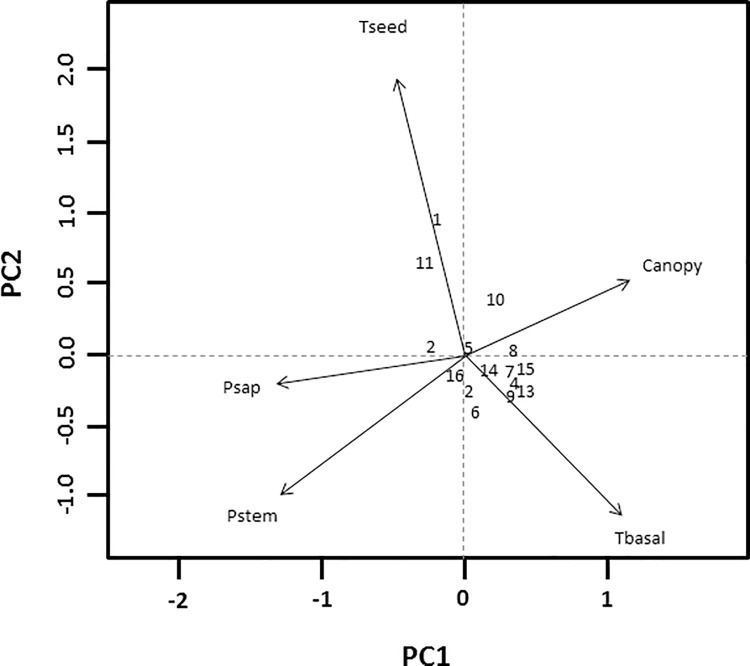
Distance biplot of final principal components analysis with Scaling 1 for site and species scores.Sites scores are weighted sums of species scores and scaled proportional to eigenvalues. Species are un-scaled with weighted dispersion equal on all dimensions. Variables include Total Basal Area, Total Seedling Density, Pine Stem Density, Pine Sapling Density, and Percent Over-story Canopy Cover. Sites: 1–5 represent successful nests, sites: 6–8 represent failed nests and sites: 9–16 represent random plots.